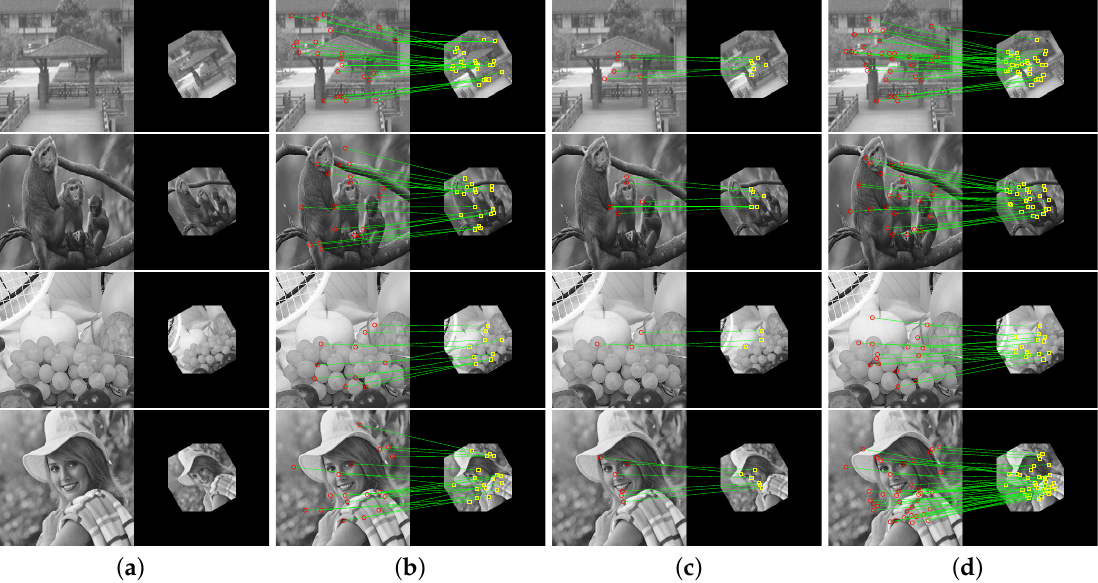
Figure 10. Matching results of scaled and rotated and images: ( a ) Harris results; ( b ) SIFT results; ( c ) PCA-SIFT results; ( d ) our